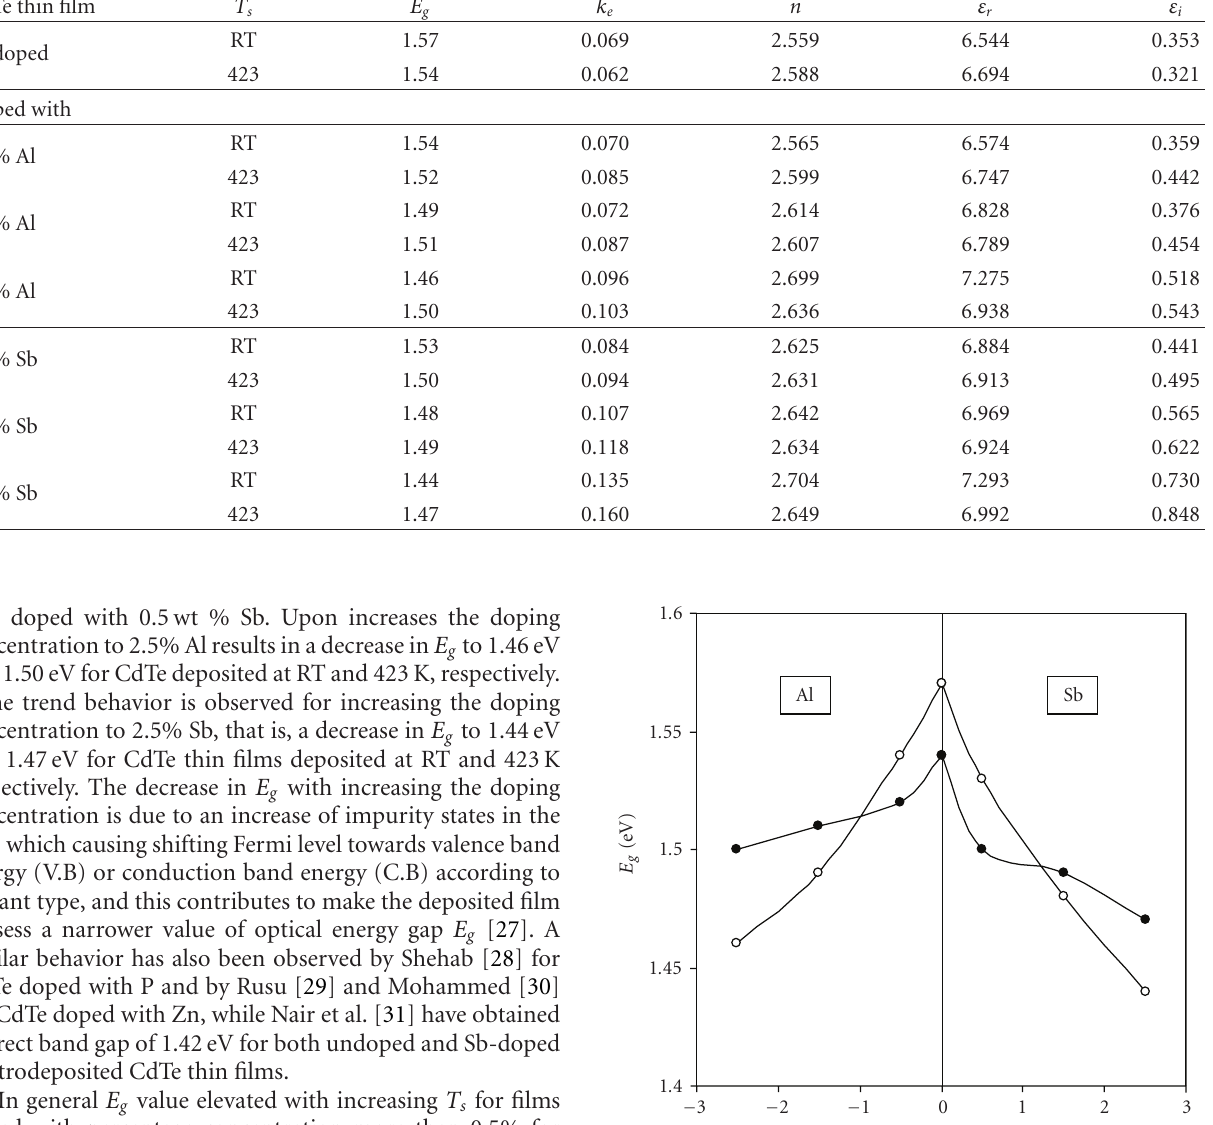
Table 1: Values of E g , k e , n , ε r , and ε i for undoped and doped CdTe thin films deposited with T s = RT and 423 K at λ = 0.82 μ m. CdTe thin film